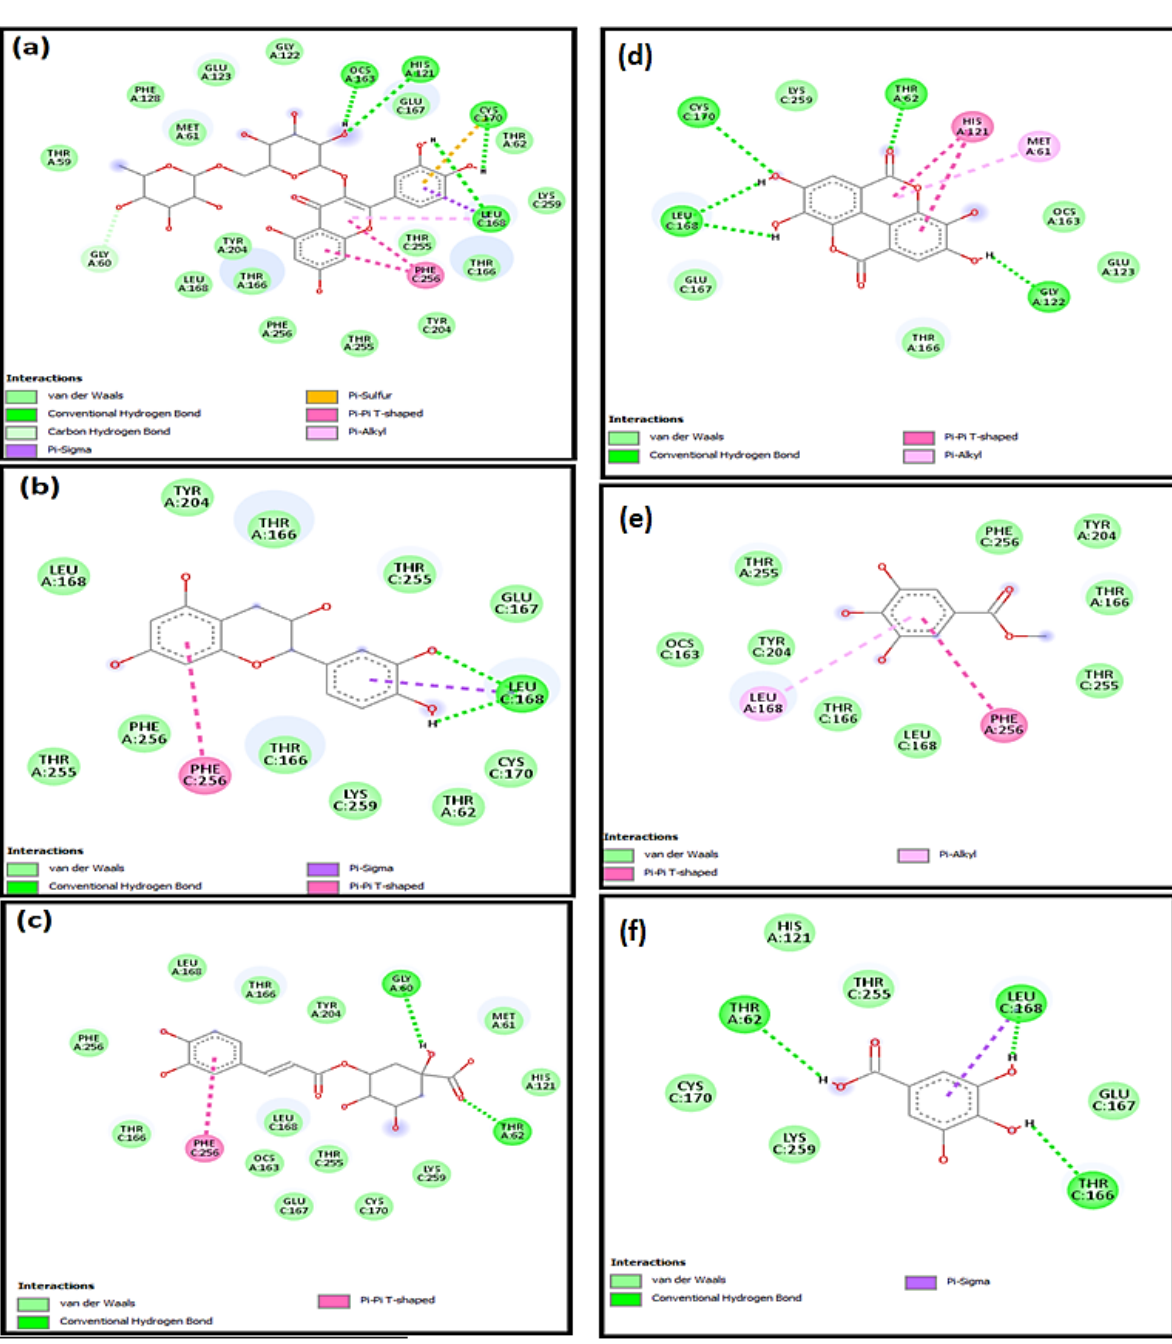
Figure 12. The 2D schematic interactions of docked ( a ) RUT, ( b ) CAT, ( c ) CHL, ( d ) ELL, ( e ) GAT, and ( f ) GAL into the caspase-3 protein (Code: 3DEI).